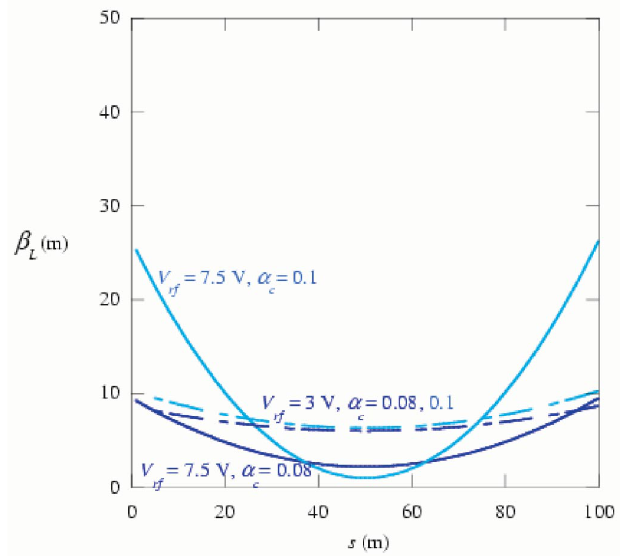
FIG. 5. (Color) Longitudinal beta function along the ring for (cid:6) 0 : 08 and 0.1 in the monotonic case for two values of V (cid:1) c and 7.5 MV). Darker color corresponds to lower a